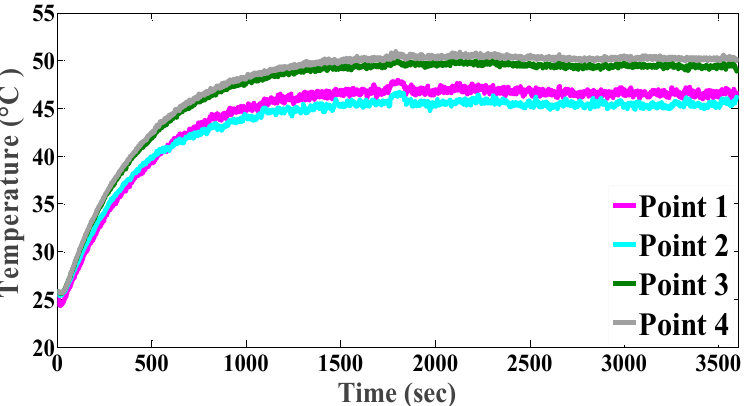
Figure 23. Temperature responses in Type II heat-source point.